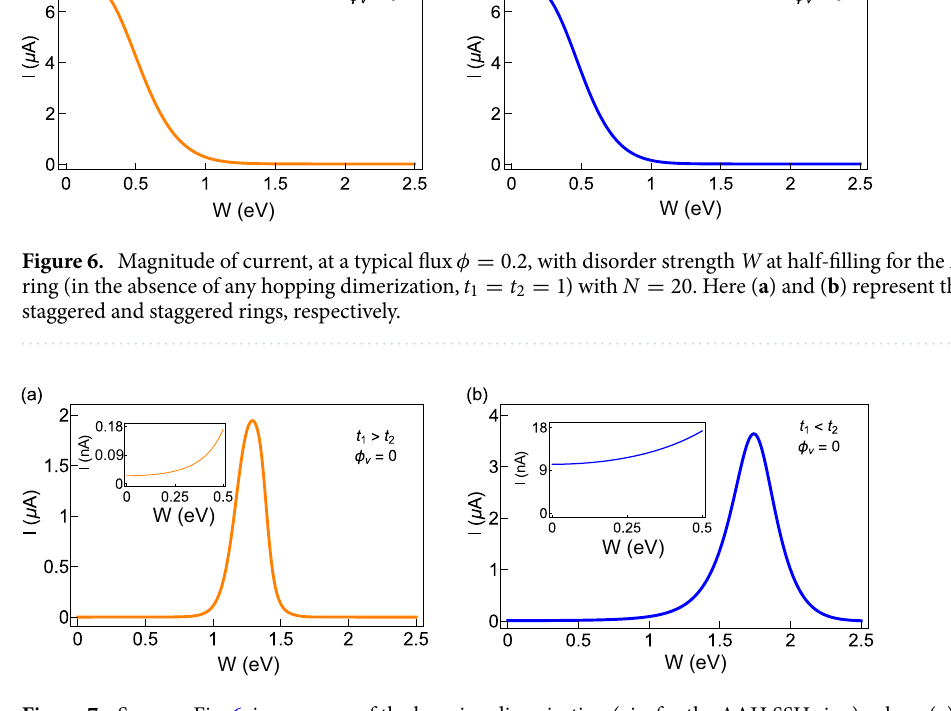
Figure 7. Same as Fig. 6, in presence of the hopping dimerization (viz, for the AAH SSH ring), where ( a ) t 1 = 1 , t 2 = 0.5 and ( b ) t 1 = 1 and t 2 = 1.5 . Insets are included to show that current is finite at low disorder strengths.